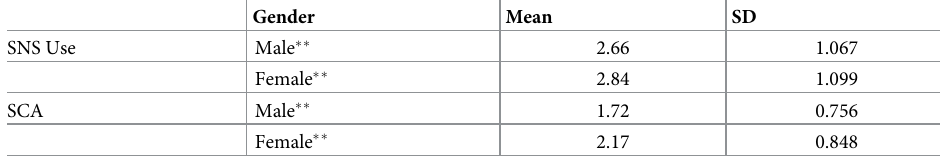
Table 5. Self-centered appearance focused use of social media (SCA) and social media (SNS use) use by gender.